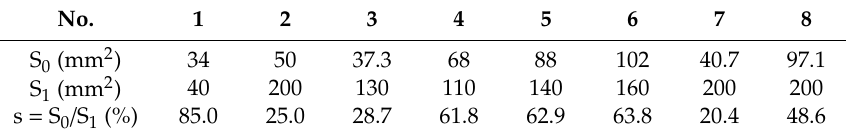
Table 4. Welding area (S 0 ), cycling area (S 1 ), and area ratio (s) of the designed